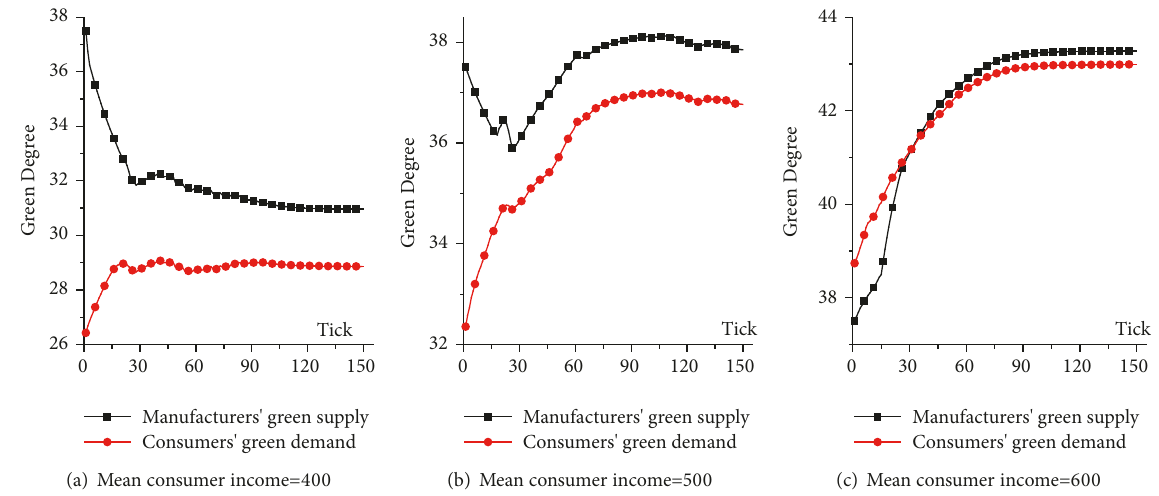
Figure 4: Green degree of manufacturers’ supply and consumers’ demand under different scenarios.